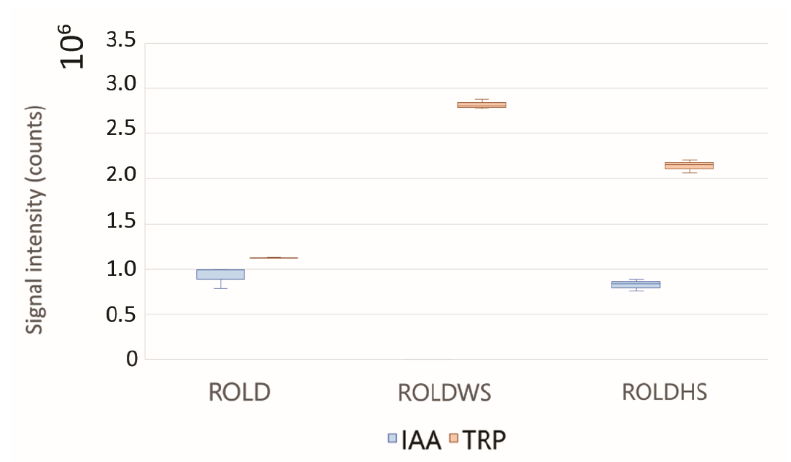
Figure 4. Box plots of tryptophan (TRP) and indole-3-acetic acid (IAA), the most important auxin in plants. 10 X specifies the unit of visualization.